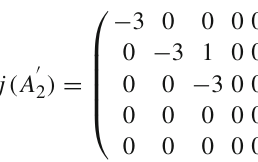
and the real Jordan matrix